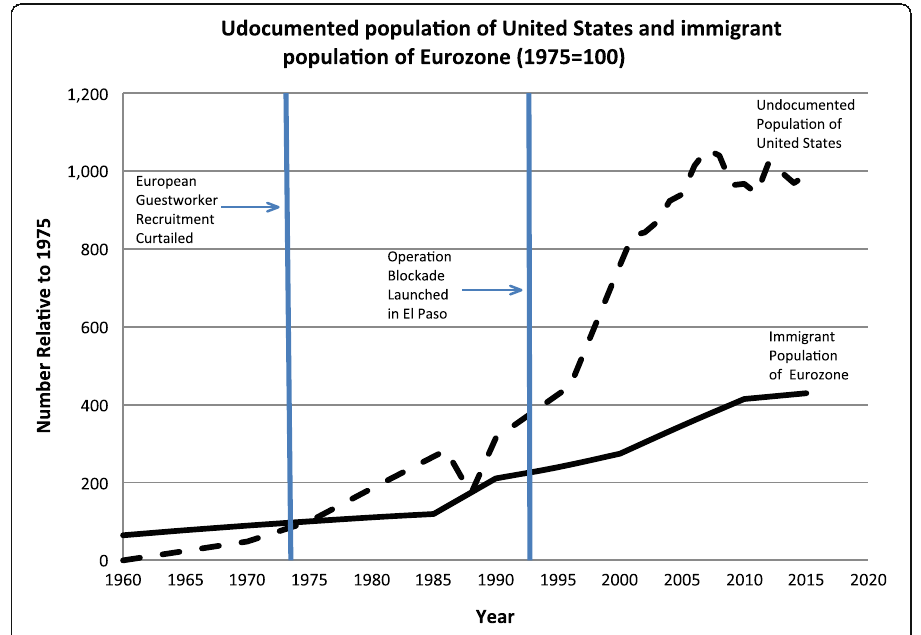
Fig. 1 Undocumented population of United States and immigrant population of Eurozone (1975 =